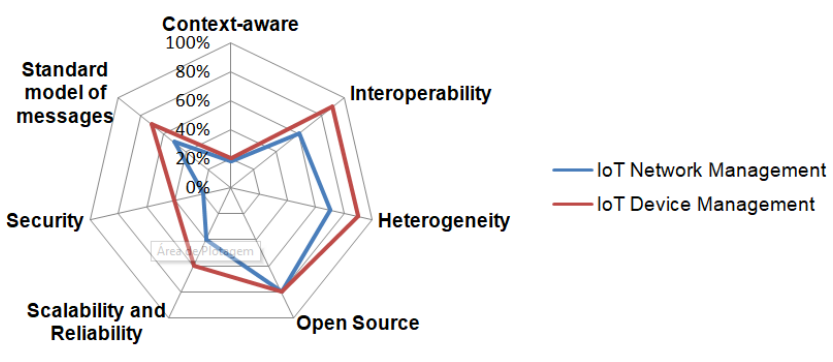
Figure 30. Percentage of resources used in IoT management protocols and